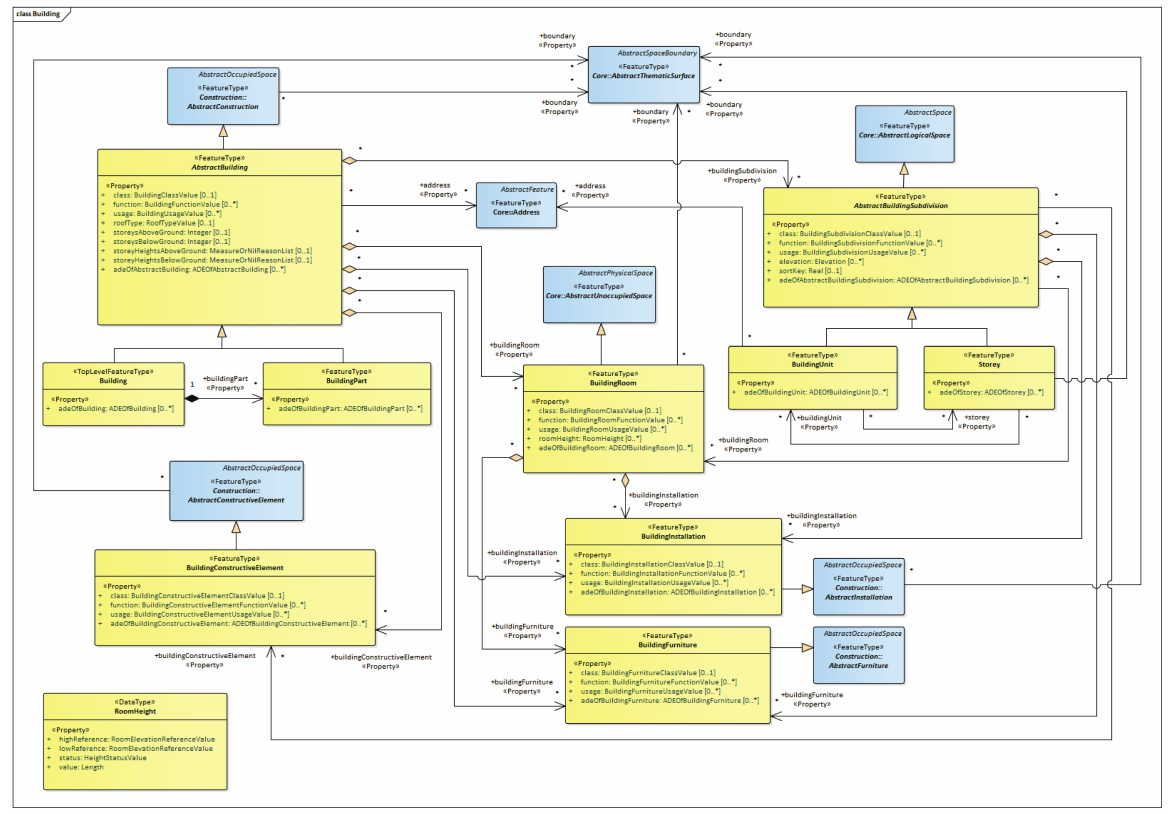
Figure 1. CityGML 3.0 Building module (OGC,